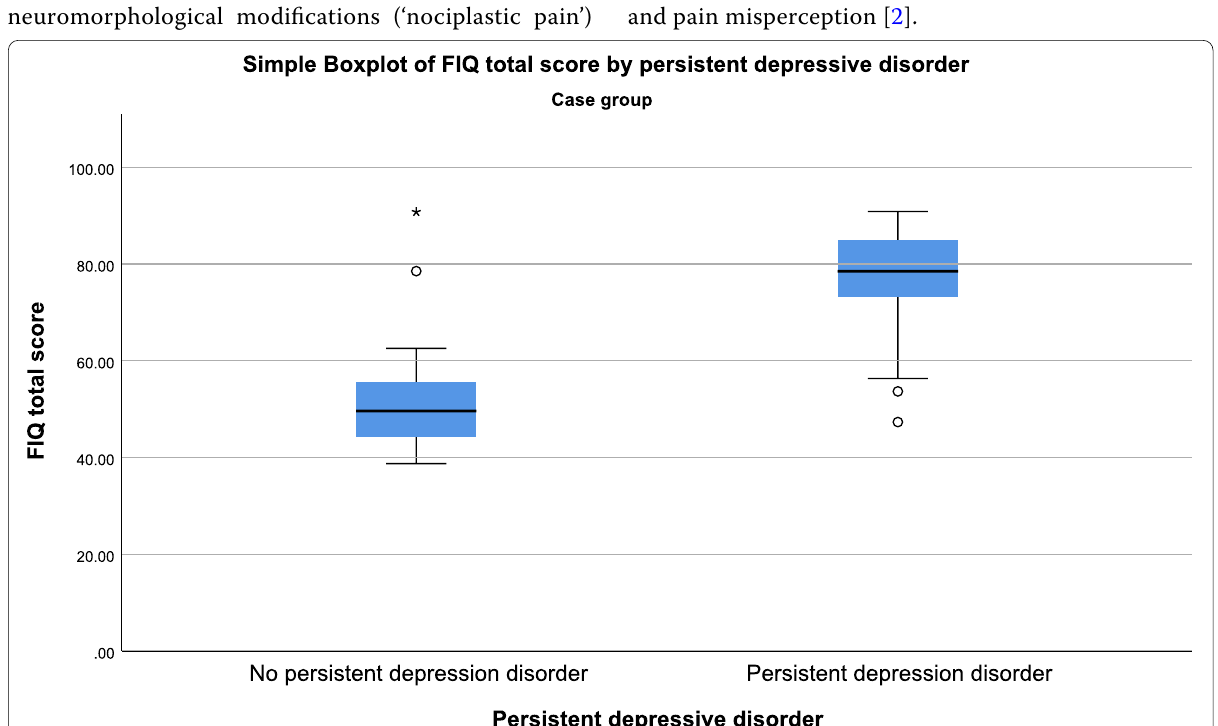
Fig. 3 Bar graph showing that fibromyalgia patients with persistent depressive disorder had significantly higher disease activity in comparison to those without persistent depressive disorder using the Kruskal-Wallis test (